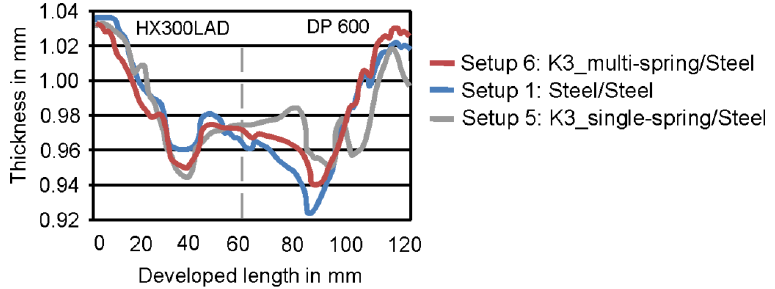
Figure 8. Comparison of thickness distribution for setups 1, 5 and 6.